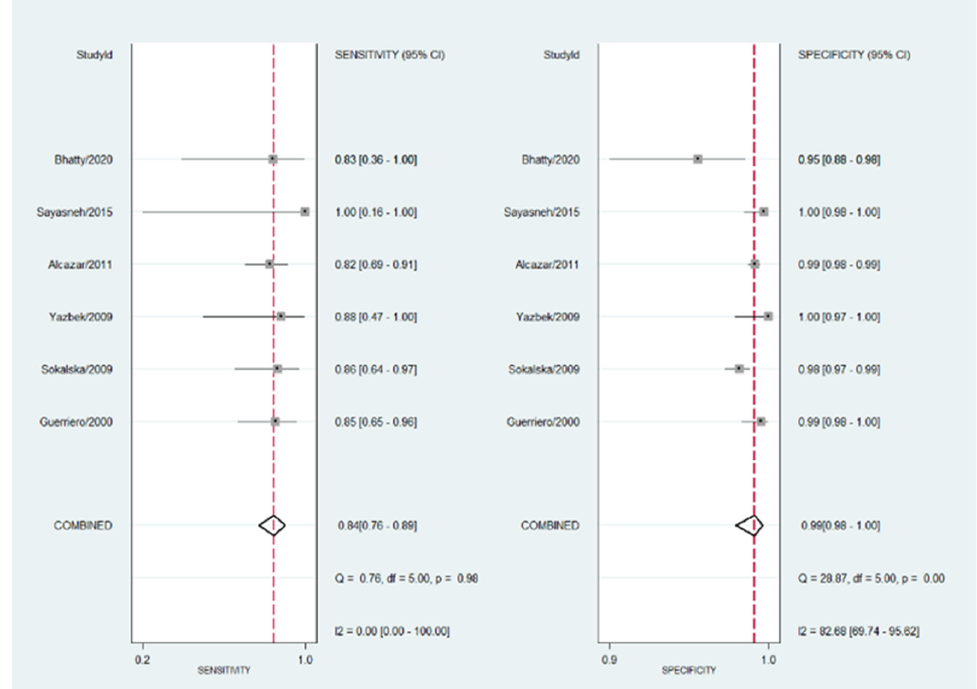
Figure 2. Forest plot for sensitivity and specificity for all the studies included in the meta-analysis. The heterogeneity is shown as well as the pooled sensitivity and specificity. Refs. [16–21]. Meta-regression shows that neither sample size, year of publication nor prevalence of hydrosalpinx in each article explained the heterogeneity observed for the specificity. However, when re-analyzing the data excluding the two studies with lower positive pre- dictive value (PPV) [17,20], the heterogeneity for the pooled estimated specificity is lower, without changes in this last value (specificity = 99%) (Figure 3).